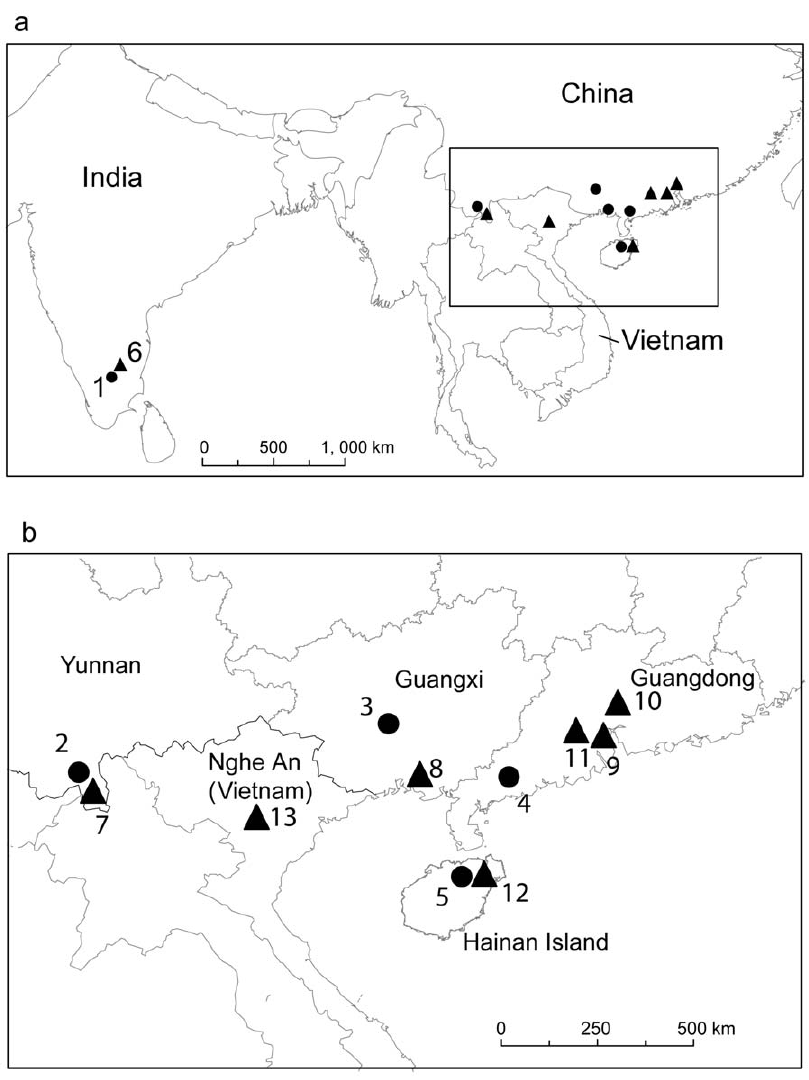
Figure 1. Sampling locations for Cynopterussphinx and Rousettusleschenaulti. Map of the sampling locations for Cynopterus sphinx (triangles) and Rousettus leschenaulti (circles) across a) whole sampling range and b) detailed view of sampling sites and provinces in China and Vietnam.